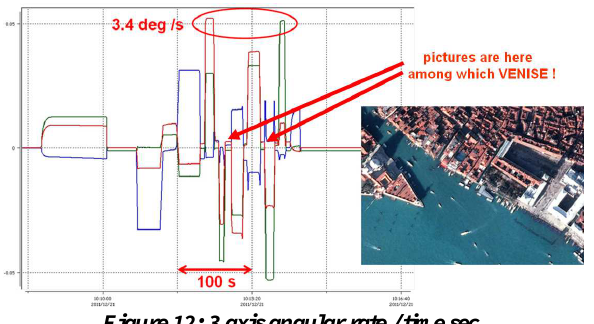
Figure 12: 3 axis angular rate / time sec